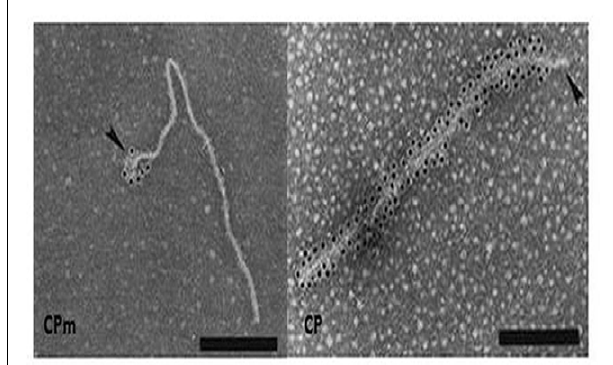
FIGURE 4 | Immunogold labeling of LIYV virions using antibody against CP and CPm . Gold labeling is indicated by the black dots, note that the CPm only encapsidates a short segment at one end of the virion while CP composes the remainder of the capsid. Image fromTian etal. (1999) with